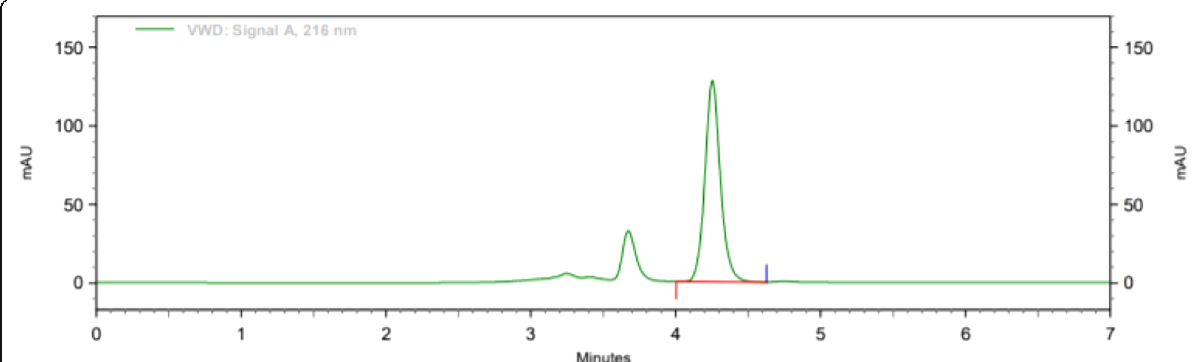
Fig. 6 Typical chromatogram of SST for brexpiprazole